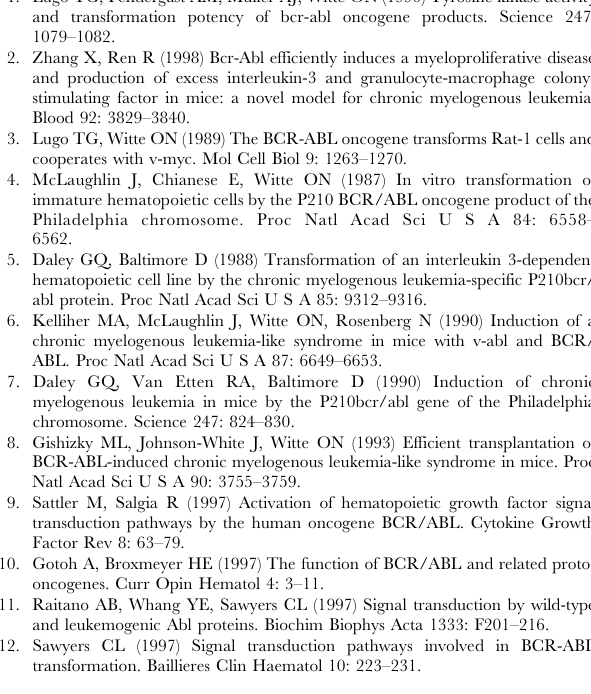
Figure S1 Growth curves of the triple mutant and BCR-ABL clones. Independent clones of 32D cells expressing either BCR- ABL wild type or triple mutant were isolated from soft agar cultures and their ability to grow in the absence of IL-3 was evaluated in cell proliferation assays. A representative cell proliferation assay with two wild type and four triple mutant clones is shown.